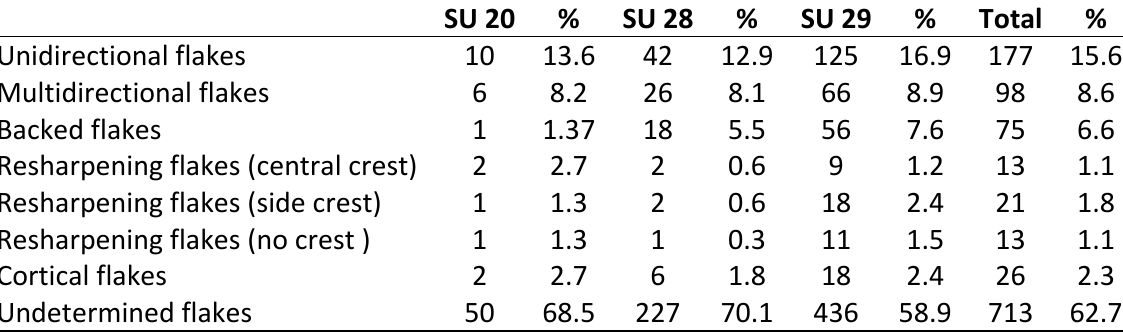
Figure 6. Juxtaposition of the extraction marks of the different stages of the operational sequence of basalt and tuff quern quarries. Table 3. Classification of flakes from the different stratigraphic units (SU) of the Cardones quern